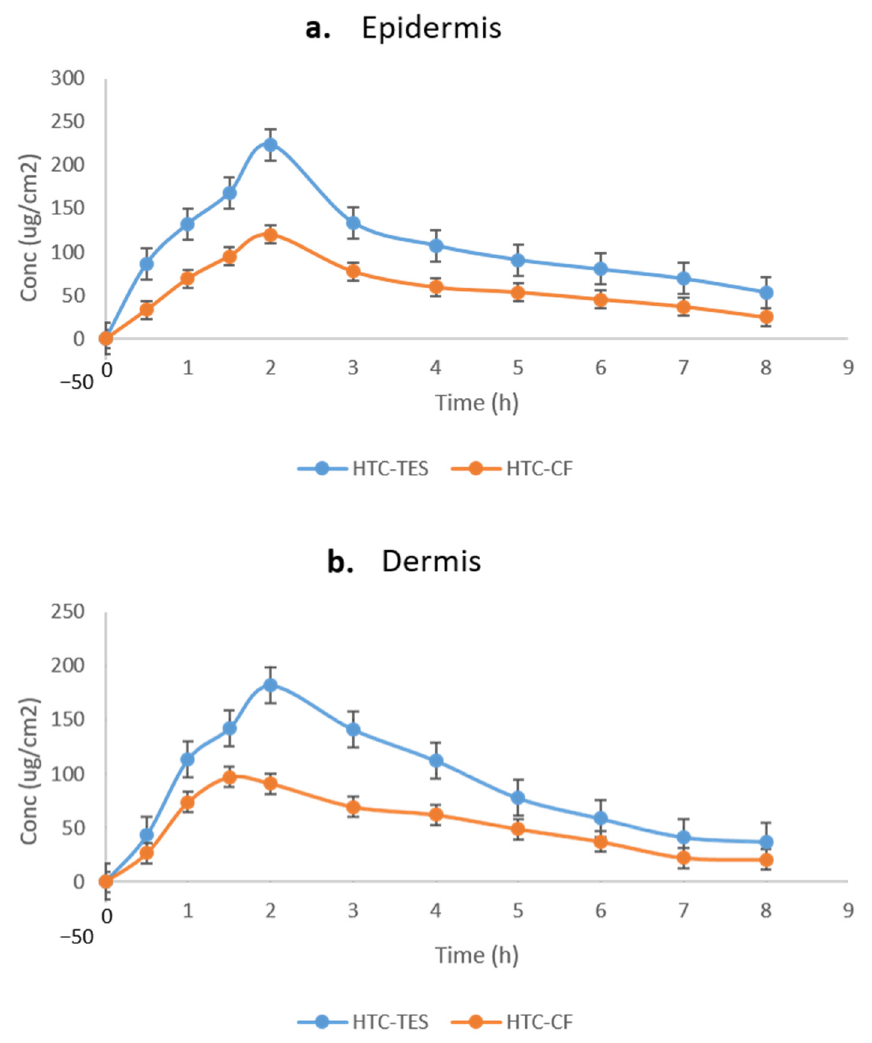
Figure 6. HTC concentration on ( a ) epidermis and ( b ) dermis after topical application of HTC-TES gel and HTC-CF gel on excised rat skin. Table 3. Dermatokinetic parameters (Mean ± SD) of HTC-TES-gel and HTC-CF-gel .